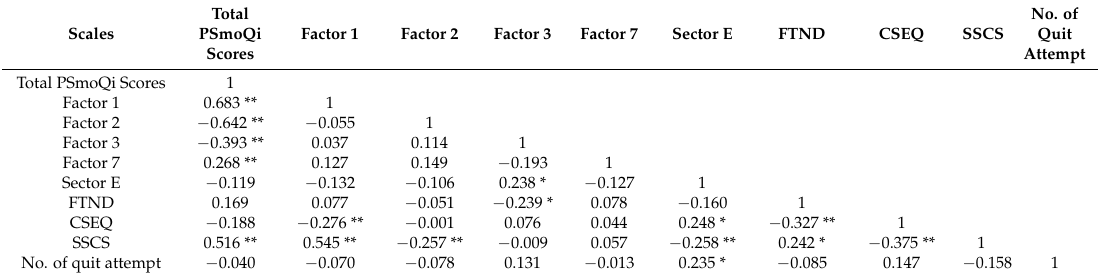
Table 11. Pearson correlation matrix for the